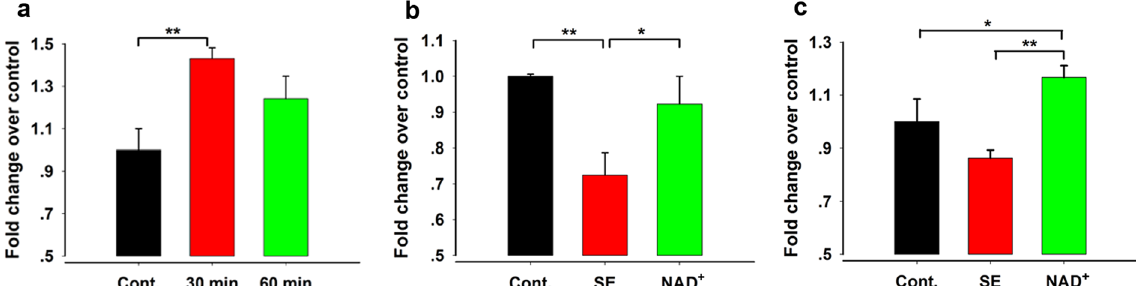
Figure 1. NAD + injections reversed NAD + depletion in SE model mice. ( a ) Exogenous supply of NAD + led to significant augmentation of NAD + in the hippocampus at 30 min after NAD + injection (Cont., N = 5; 30 min, N = 6; 60 min, N = 5). ( b , c ) Changes in the NAD + level in the hippocampus of control, SE model mice, and NAD + -treated SE mice at 24.5 h (Cont., N = 5; SE, N = 6; NAD + , N = 6) and 1 h (Cont., N = 4; SE, N = 6; NAD + , N = 6) after SE. Cont., SE, and NAD + represent the control, SE model mice, and NAD + -treated SE mice, respectively. Data are represented as mean ± SEM. * P < 0.05, ** P < 0.01, *** P <